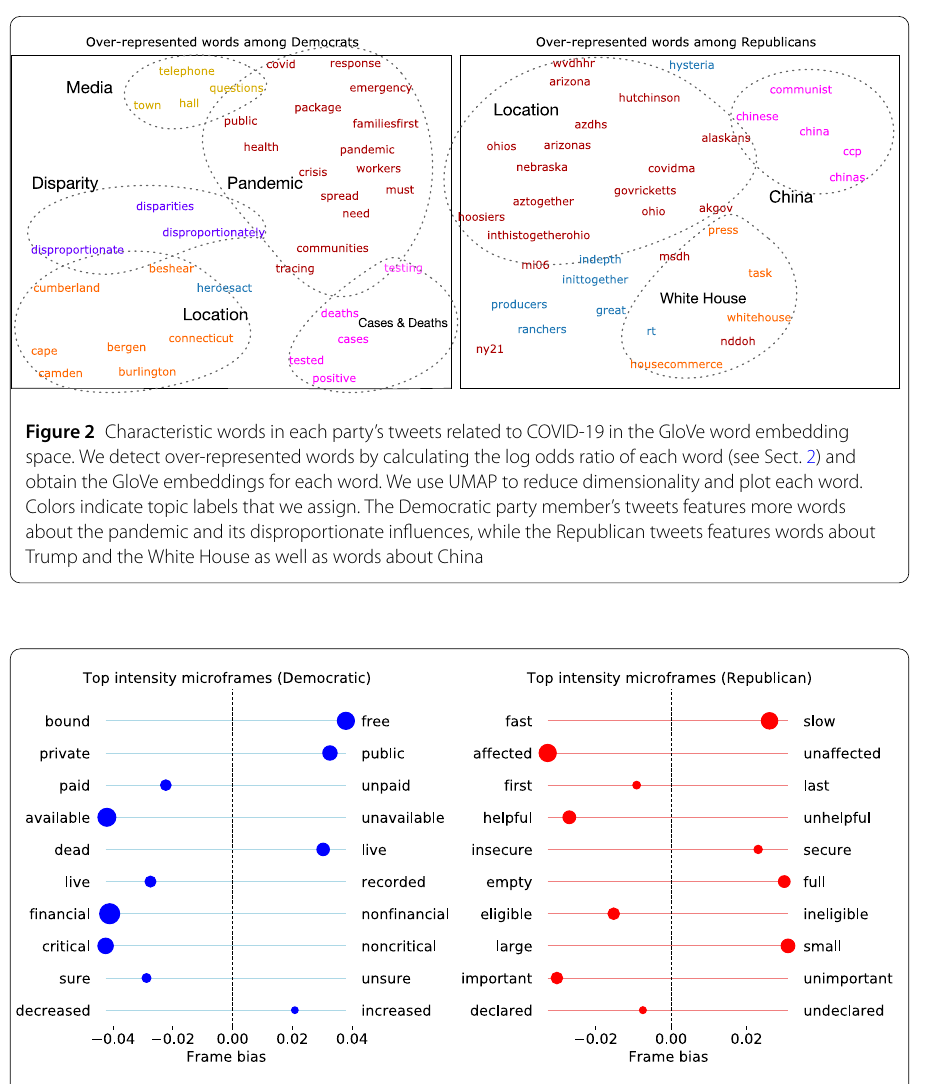
Figure 3 Top 10 microframes with the largest intensity differences between parties, as well as their frame bias. The position of points indicate the values of bias, and the size of points indicate the values of